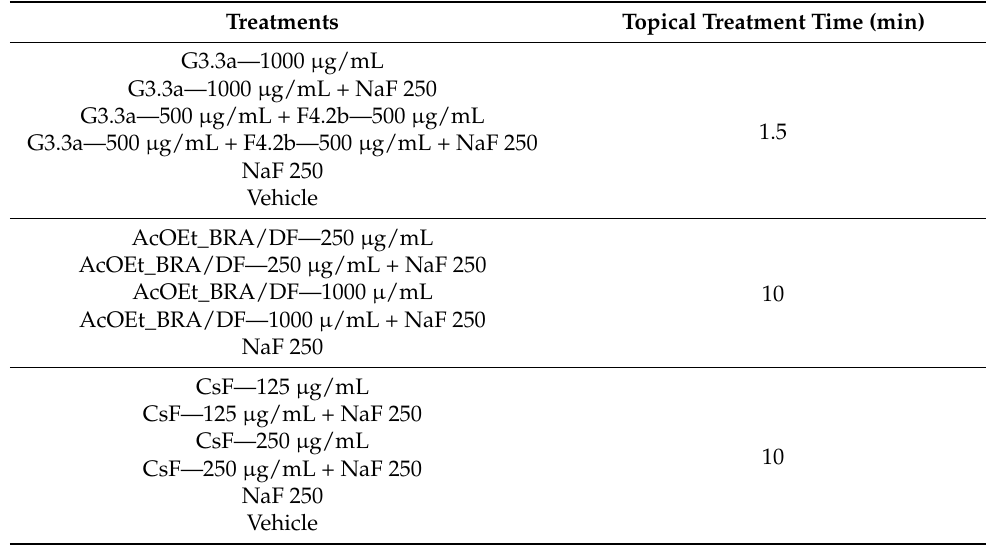
Table 4. Formulations used to topically treat biofilms formed on sHA